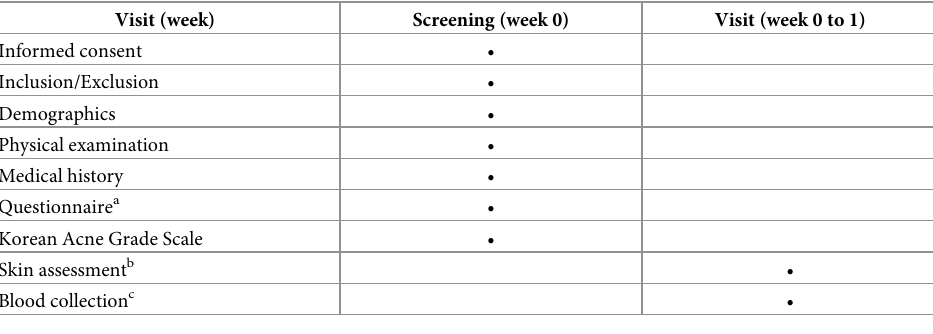
a pattern identification inventory, smoking, sleep, stress response inventory, and dietary habits b skin temperature, skin stiffness (cutaneous resonance running time), and sebum levels c androgens, serum lipids, amino acids, and